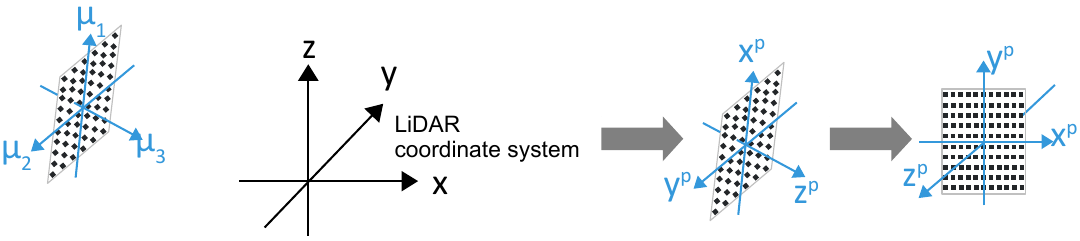
Figure 6. Directions of the basis vectors relative to the LiDAR coordinate system. Blue arrow lines in the left figure represent the basis vectors decomposed by PCA. After transformation with the basis vectors, chessboard’s points are mapped to the X P OY P (chessboard plane). Then we can apply the model described in Figure 5.